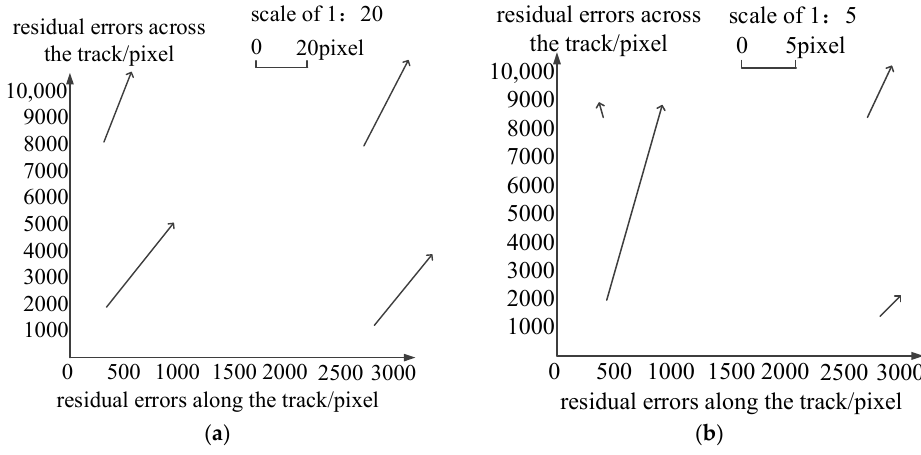
Figure 13. Residual distribution of the check points: ( a ) Residual distribution of calibration offset; ( b ) residual distribution parameter compensation (without GCP).